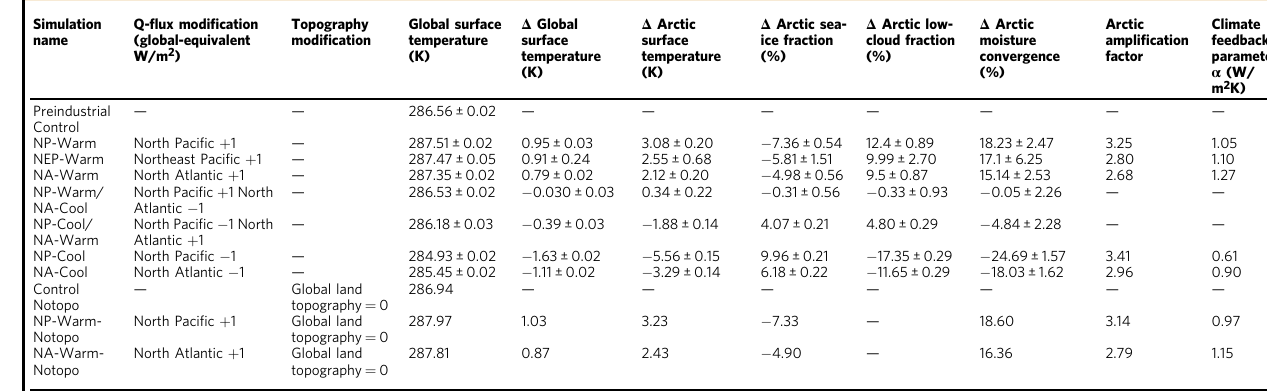
Table 1 Summary of simulations conducted in this study Simulation